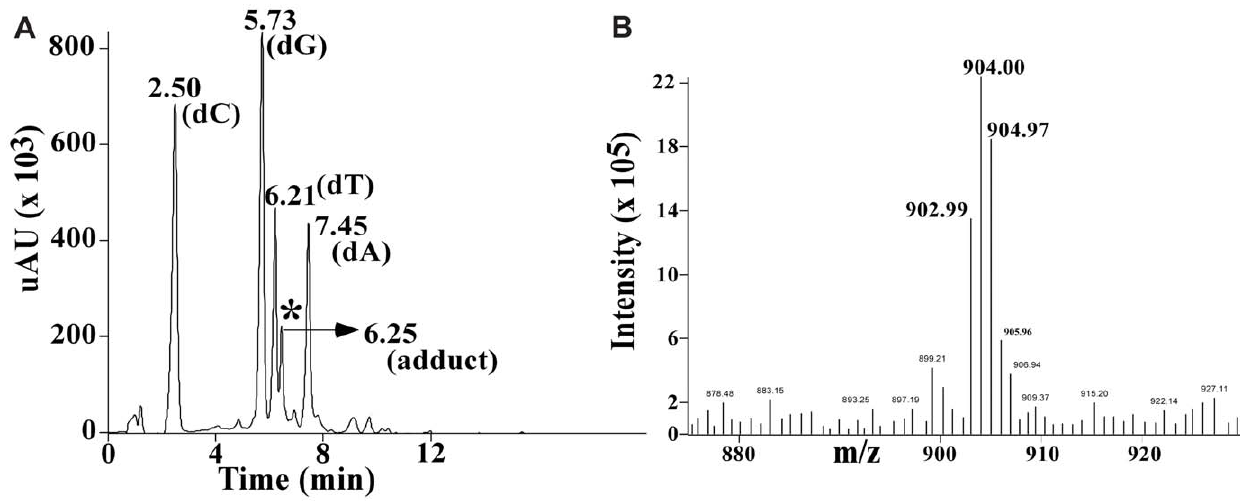
Figure 10. Purity of the duplex DNA used for NMR experiments. The spectra include the HPLC 2 UV elution profile of the digestion products obtained from the 12-mer duplex containing the OX 2 GG adduct [the peak with an asterisk corresponds to the elution position of a OX 2 d(GpG) standard] ( A ), and MS-positive ion mass spectrum of the peak identified with the asterisk in Figure 2A ( B ).